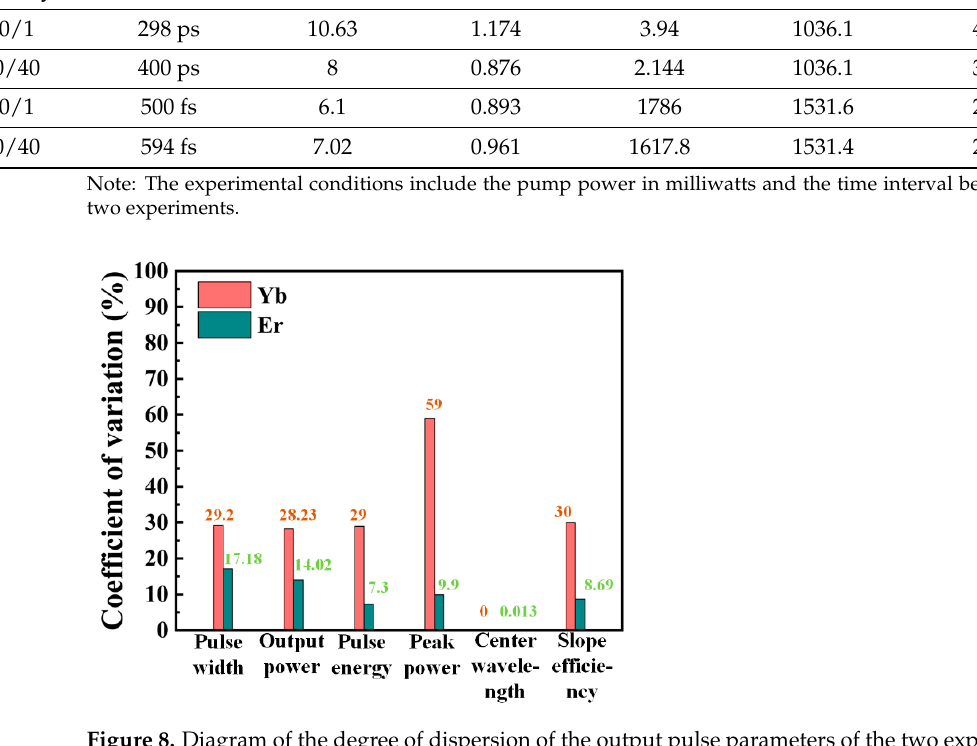
Figure 8. Diagram of the degree of dispersion of the output pulse parameters of the two experi- ments.